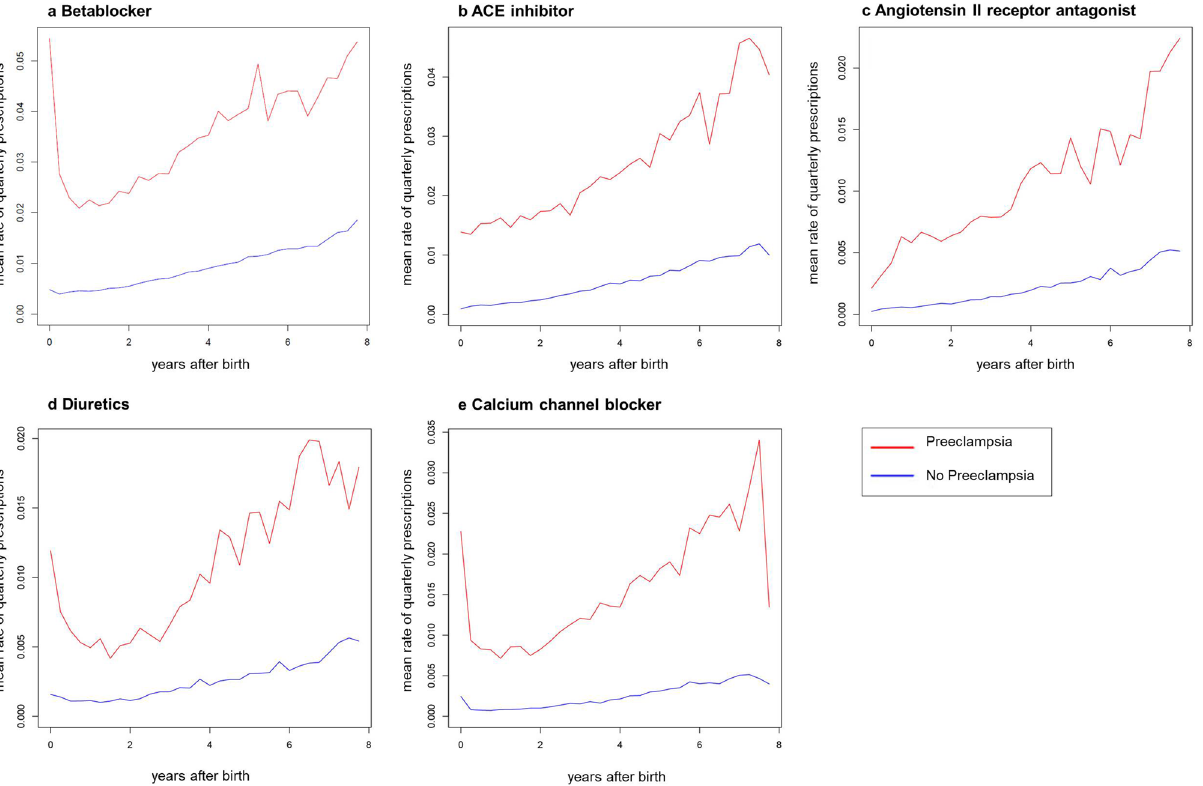
Figure 3. Prescription of antihypertensive medication in patients with and without PE. Mean rates of betablockers ( a ), ACE inhibitors ( b ), angiotensin II receptor antagonists ( c ), diuretics ( d ), and calcium channel blockers (e) prescribed quarterly and stratified for patients with (red) and without PE (blue) after